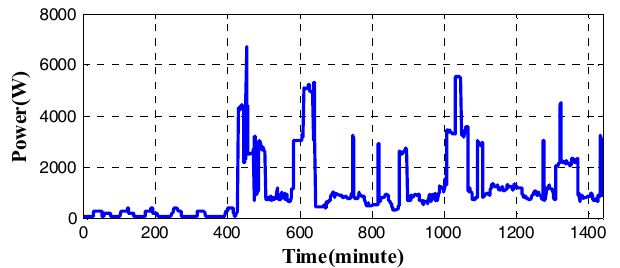
Figure 12. Load simulation of a residential house.